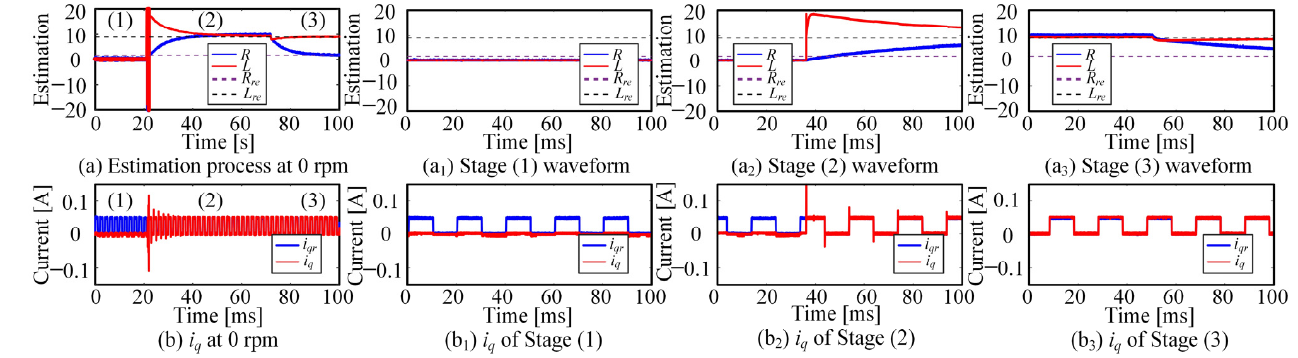
Figure 11. The parameter identification results at 0 rpm.